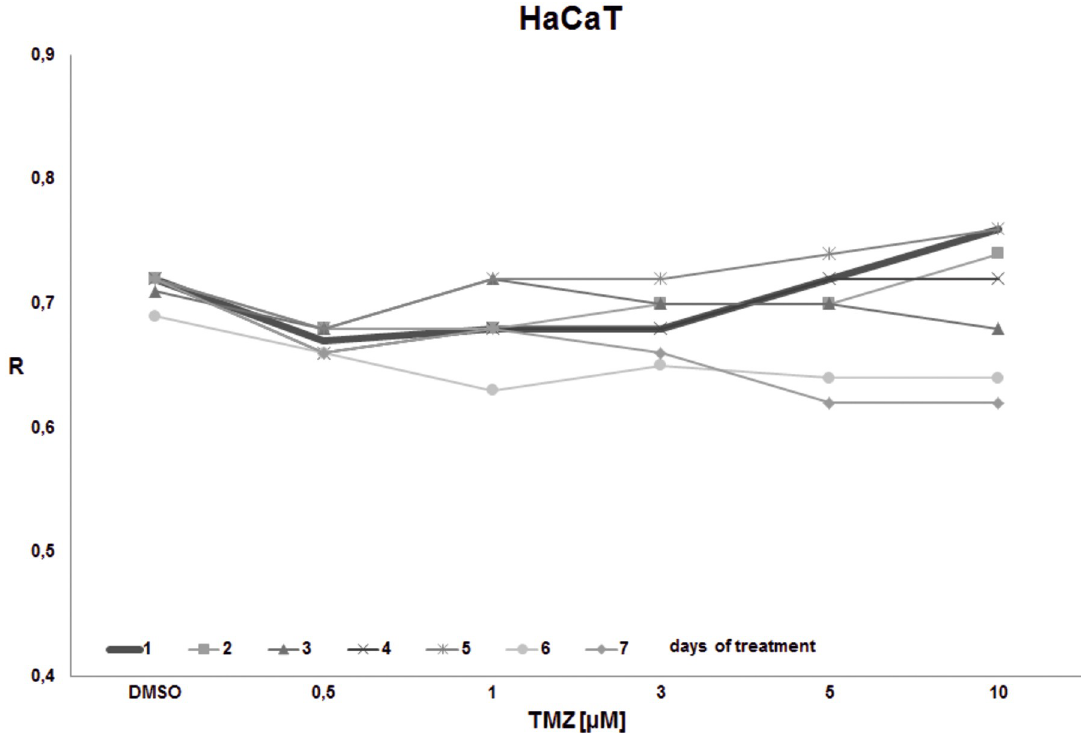
Fig 11. The impact of TMZ exposure period on DNA methylation in HaCaT cell line. HaCaT cell culture was treated with the given single dose of TMZ (0.5, 1, 3, 5, 10 μ M) and left for 1–7 days. The global DNA methylation was estimated after 1 st , 2 nd , 3 rd , 4 th , 5 th , and 7 th day of incubation. No significant change in DNA methylation is observed during